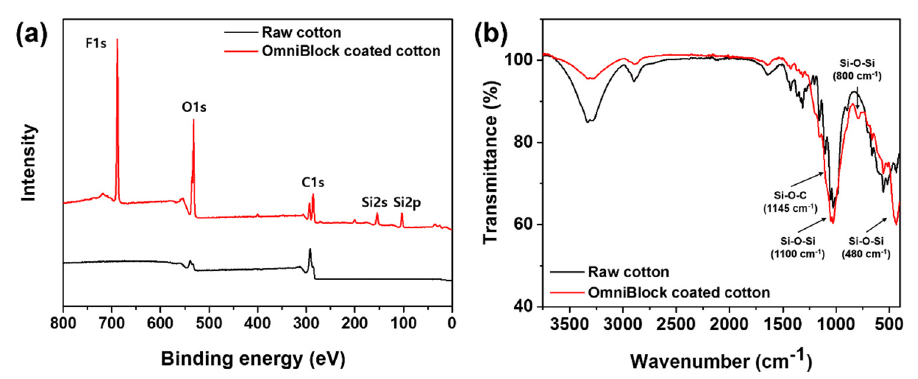
Figure 3. ( a ) XPS spectra of and ( b ) ATR-FTIR spectra of raw cotton fabric and OmniBlock-coated cotton fabric.